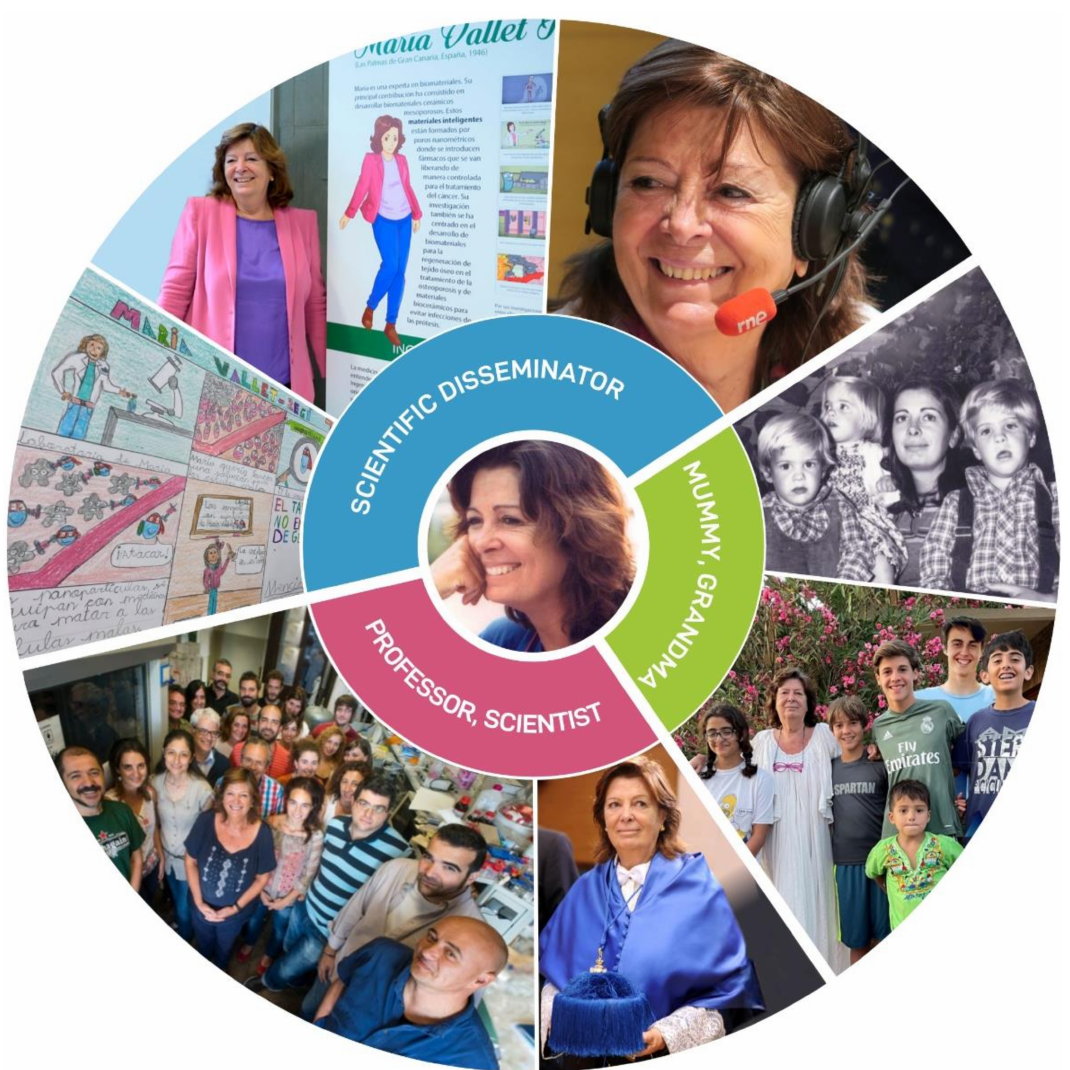
Figure 2. Schematical depiction of Mar í a Vallet-Reg í ’s different facets, which include professor and scientist, scientific disseminator, and mummy and